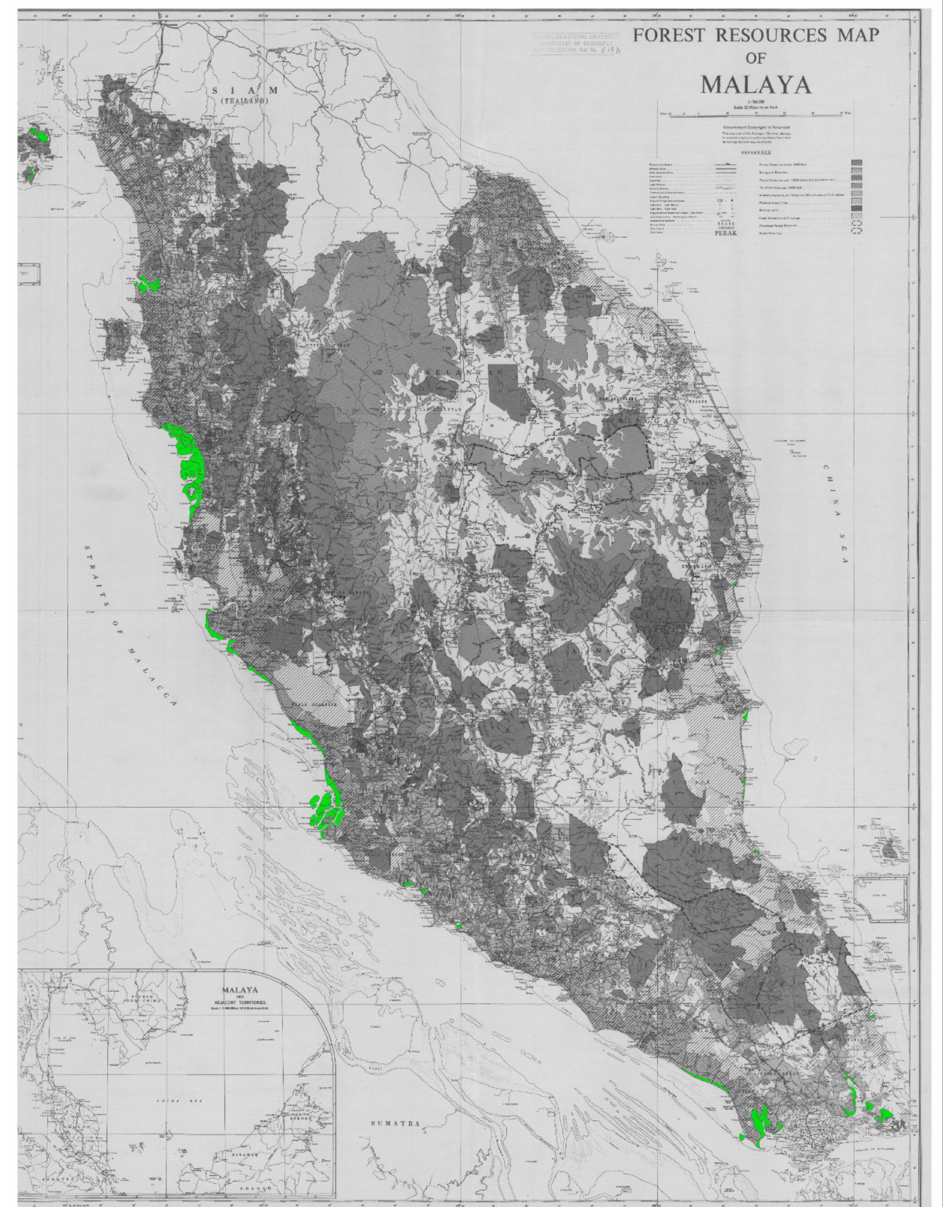
Figure 5. Mangrove cover classification on Forest Resources Map of Malaya, 1954 (hdl:1885/140842, Australian National University). The areas in green indicate the detection of mangrove forests. The map is displayed in grayscale to make the digitised mangrove area more